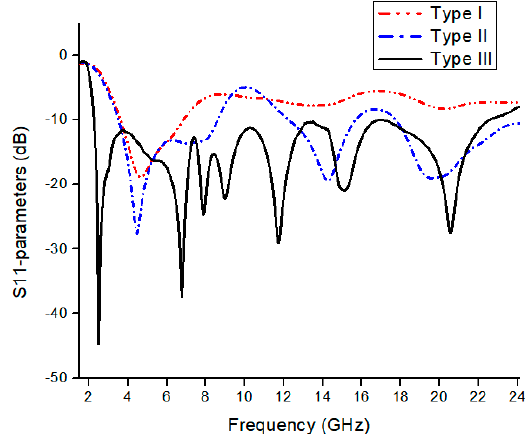
Figure 3. Reflection coefficients of the design phases.